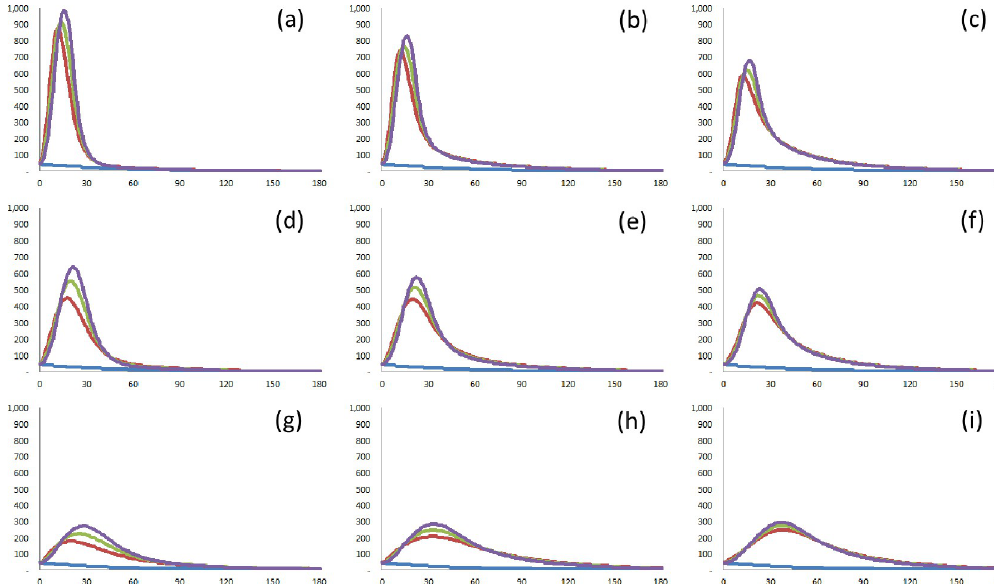
Fig 8. Demonstration of the effects of the speed of testing. The confirmed cases without a new wave (blue solid line), the confirmed cases with I med = 3.7 (red solid line), the confirmed cases with I med = 5.6 (green solid line), and the confirmed cases with I = 7.5 (violet solid line). (a) q = 0.4, A = 1.0. (b) q = 0.4, A = 0.75. (c) q = 0.4, A = 0.5. (d) q = 0.2, A = 1.0. (e) q = 0.2, med A = 0.75. (f) q = 0.2, A = 0.5. (g) q = 0.1, A = 1.0. (h) q = 0.1, A = 0.75. (i) q = 0.1, A = 0.5.